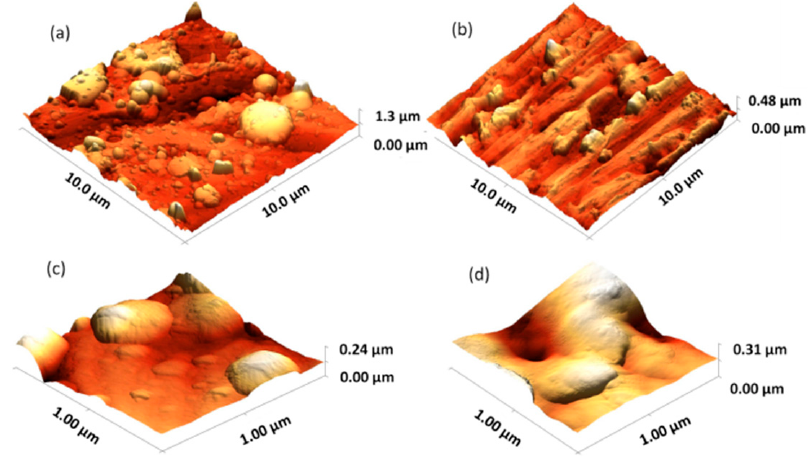
Figure 4. AFM images of ( a , c ) 13-93 and ( b , d ) 13-93-B3 BG coated Ti.